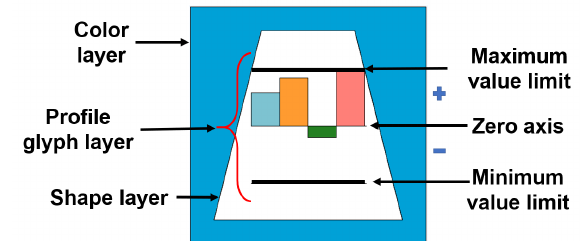
Figure 4. A layered glyph with three layers. The top layer presents a profile glyph, which represents quantitative data of four dimensions. The bars indicate positive values (above the zero axis) or negative values (below the zero axis), always respecting the reference lines that indicate the maximum and minimum size of the